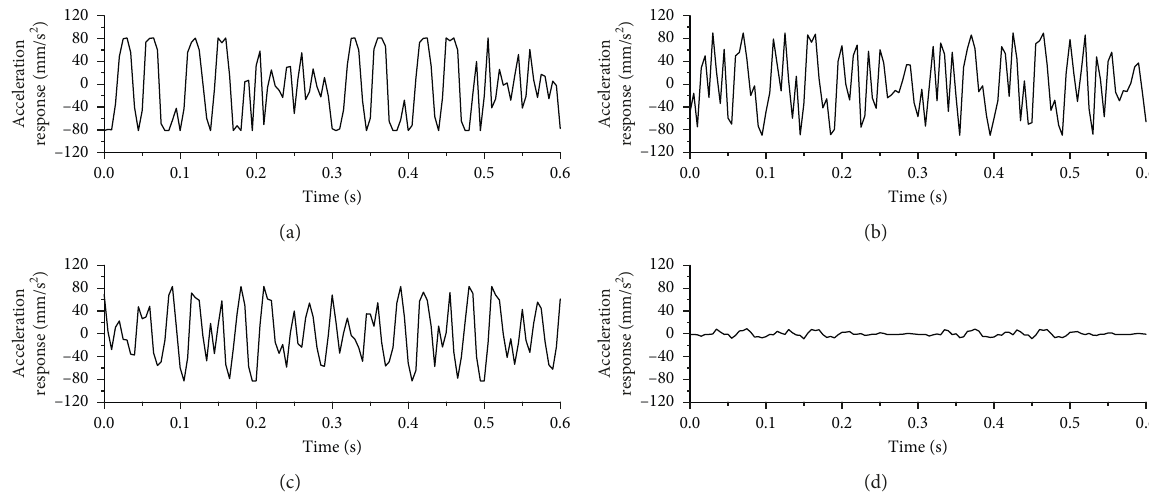
Figure 12: Acceleration at different layers with respect to time: (a) track slab; (b) surface layer of subgrade; (c) bottom layer of subgrade; (d) surface layer of